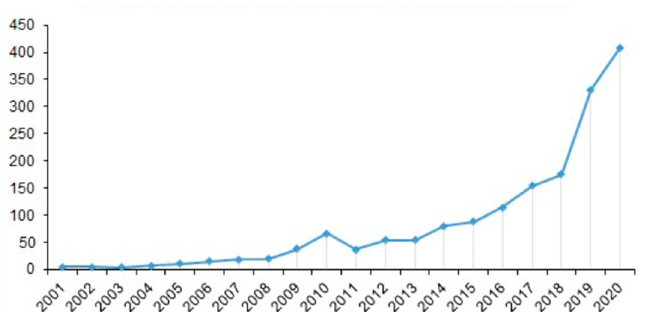
Figure 1. Timespan of publications on gut health in animals.